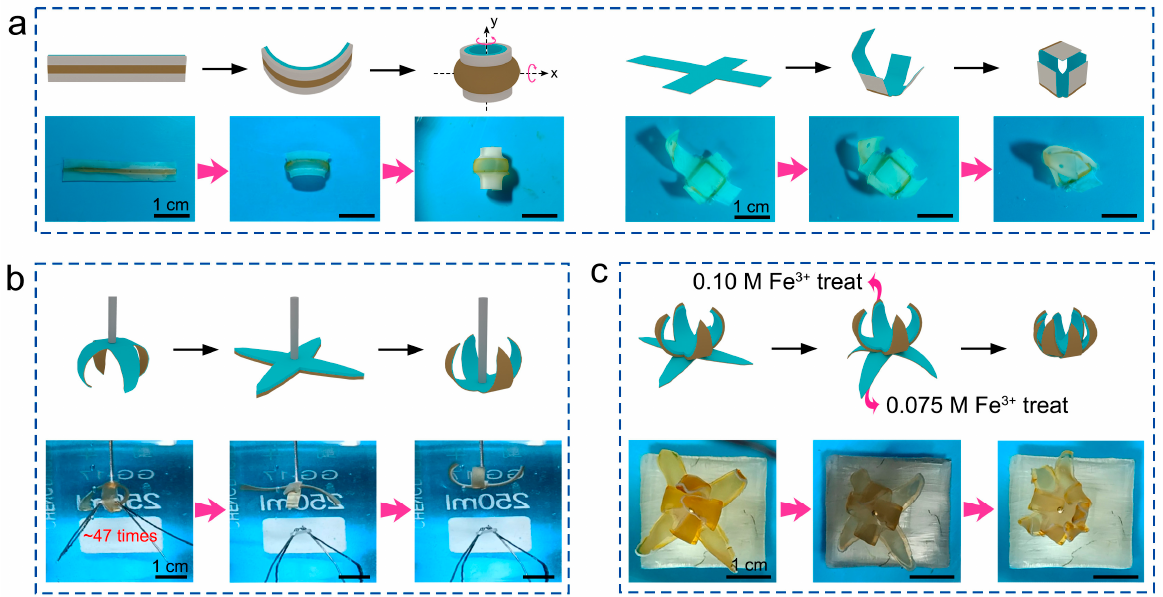
Figure 7. ( a ) Asymmetric deformation from planar sheet to lantern and folded box. ( b ) “Capturing-releasing” process of a plastic block by a cross-shaped hydrogel in pH = 13. ( c ) Multi-step deformation of the biomimetic hydrogel flower (the hydrogel petals are treated with 0.075 and 0.10 M Fe 3+ , respectively).